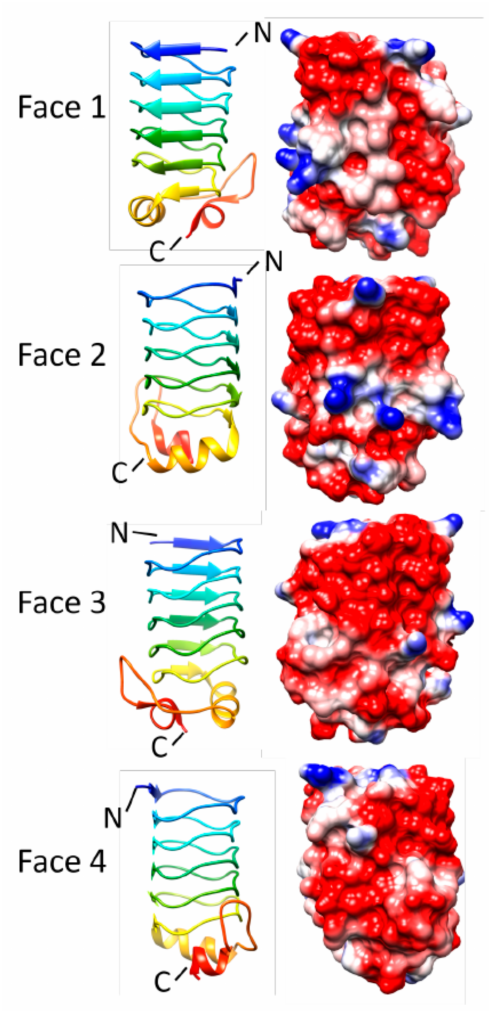
Figure 17. Structure and analysis of Rfr32. Ribbon diagrams of the structure (PDB ID: 2G0Y) for four different orientations (at left) and the corresponding electronic potential surface plots (at